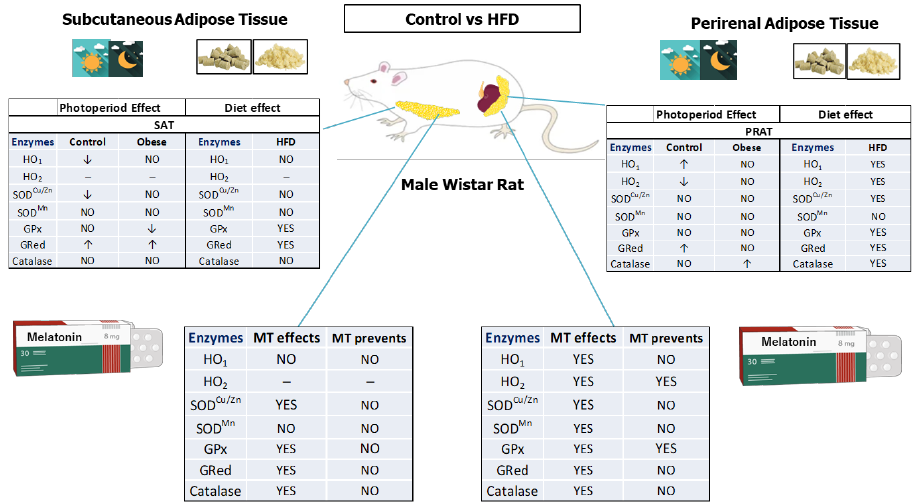
Figure 5. Graphical abstract including effects of photoperiod, diet, and possible preventive effects of Melatonin on 09:00 a.m. vs. 01:00 a.m. gene expression of redox enzymes in PRAT and SAT of male Wistar rats fed a control or a high-fat diet. Arrows indicate whether the relative gene expression of each enzyme is increased ( ↑ ) or reduced ( ↓ ) comparing same adipose tissue, group, and diet but different schedule.